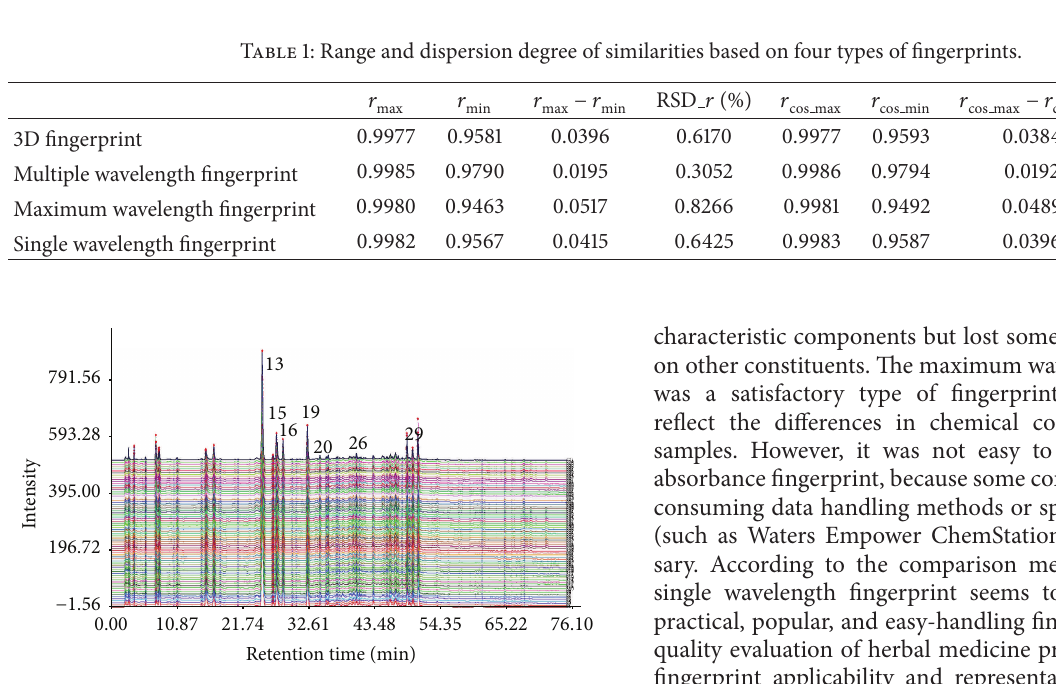
Figure 1: Typical fingerprints (single wavelength fingerprints) of 71 batches of XKS tablet samples after peak